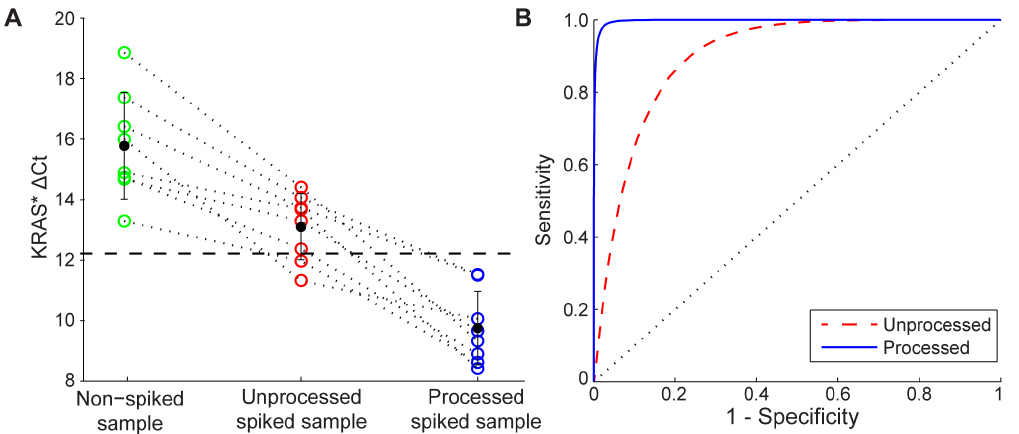
Figure 5. Enhanced RT-PCR Detection Confidence Using the Centrifuge Chip. (A) RT-PCR was performed on non-spiked, unprocessed spiked samples (0.1% purity), and processed spiked samples. KRAS* D Ct decreased in all cases (n=7), demonstrating an improved signal for the KRAS mutation. Compared to non-spiked samples, processed spiked samples exhibit a clearer KRAS* D Ct which is more distinct than for unprocessed spiked samples. The dotted black line shows a 12.2 Ct cut-off threshold for the KRAS mutation. (B) Receiver operating characteristic curves are plotted based on a Gaussian distribution of samples shown in part A. Processed samples show higher area under curve (AUC) values at 0.998 (blue, solid), compared with 0.905 (red, dashed) for unprocessed samples. portion of processed sample was immunolabeled for purity analysis. (TIF) Figure S3 Effect of cell number and purity on PCR. (A) Quantitative RT-PCR was performed on cell lines with varying cell number. Ct values for KRAS* (solid line) and GAPDH (dotted line) decreased with increasing cell number. KRAS* Ct for samples with 1,000 HeLa cells or fewer was not detected. (B)